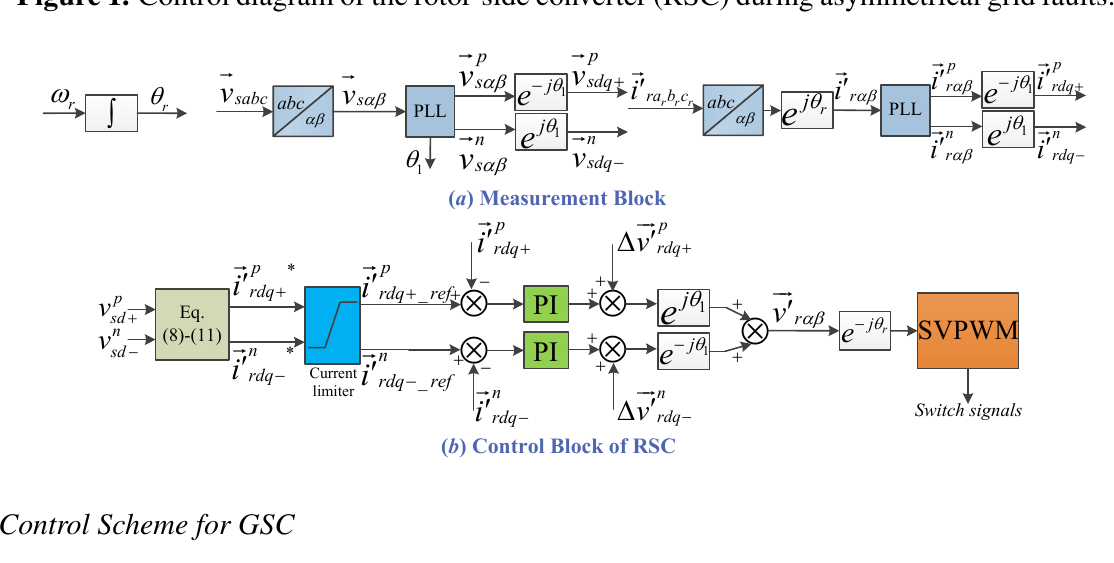
Figure 1. Control diagram of the rotor-side converter (RSC) during asymmetrical grid faults.